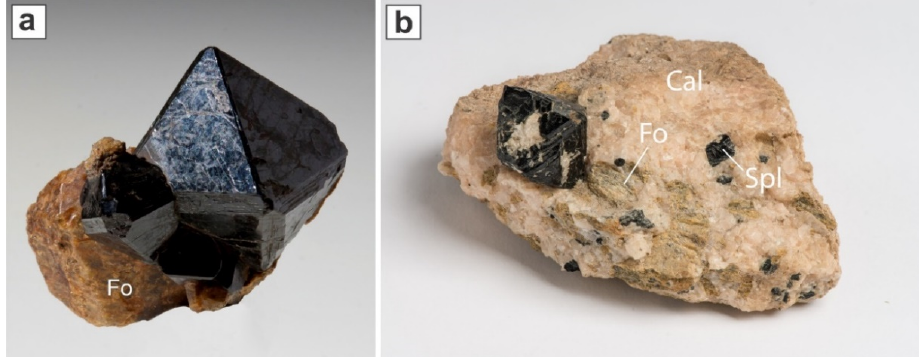
Figure 2. Large crystals of spinel from the Parker mine. ( a) . This strikingly idiomorphic crystal 1.3 cm across displays both octahedral and dodecahedral faces, as do the smaller crystals of spinel.